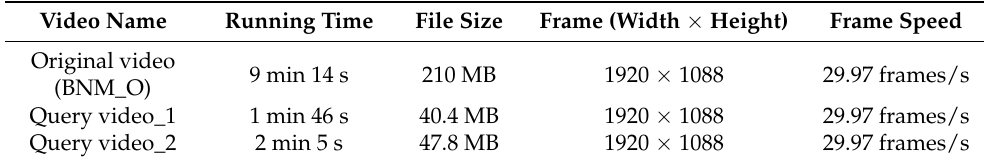
Table 8. Video secured by investigators and query videos (scenario 2).